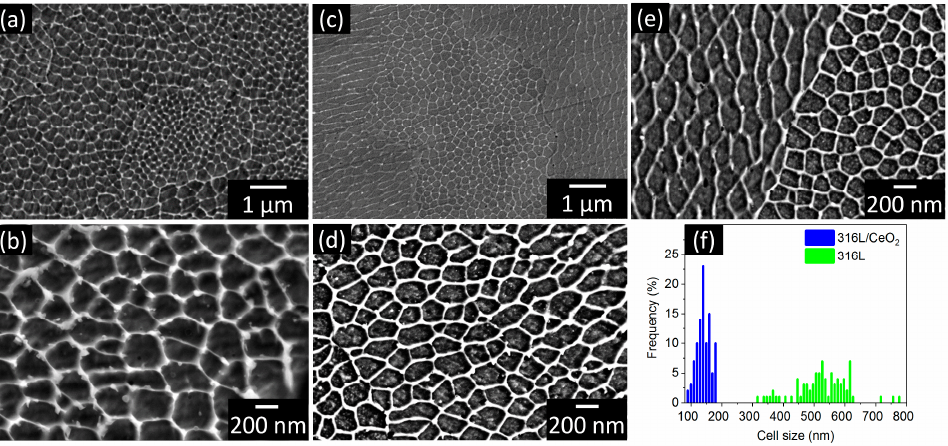
Figure 6. SEM images showing the cellular microstructure formed in ( a , b ) an unreinforced 316L specimen synthesized by SLM at 688 mm/s and ( c – e ) a 316L/CeO 2 composite synthesized at 488 mm/s; ( f ) Distribution of the cell size in the unreinforced 316L and 316L/CeO 2 composite. Grain refinement occurs at a larger length scale as well. EBSD analysis reveals that the average grain size (calculated over more than 2300 grains) of the unreinforced 316L (45 ± 3 µm) is reduced in the 316L/CeO 2 composite to about 25 ± 2 µm (Figure 7). The CeO 2 particles are thus effective grain refiners, acting as heterogeneous nucleation sites and hindering the growth of both cells and grains [46]. The reduced grain size cannot be attributed to the reduced scanning speed used in the 316L/CeO 2 composite with respect to the unreinforced 316L. Slower scanning speed would increase the depth and volume of the molten pool, consequently raising the temperature and increasing the time needed for solidification. This, in turn, would give the grains more time to grow, leading to microstructural coarsening rather than refining, in agreement with the work of Dutta Majumdar et al. [47], who